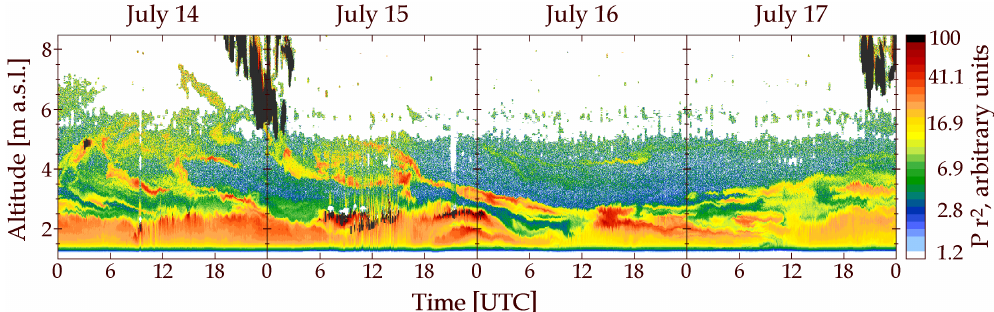
Figure 13. Range-corrected backscatter signal ( P(r)r 2 ; logarithmic colour code) measured by ceilometer over Hohenpeißenberg (southern Germany) from 14 to 17 July 2013. Areas with low signal-to-noise ratio are masked white. On 16 July, the smoke layer descended to an altitude below that of the Zugspitze summit until noon, followed by a slight rise in the afternoon.